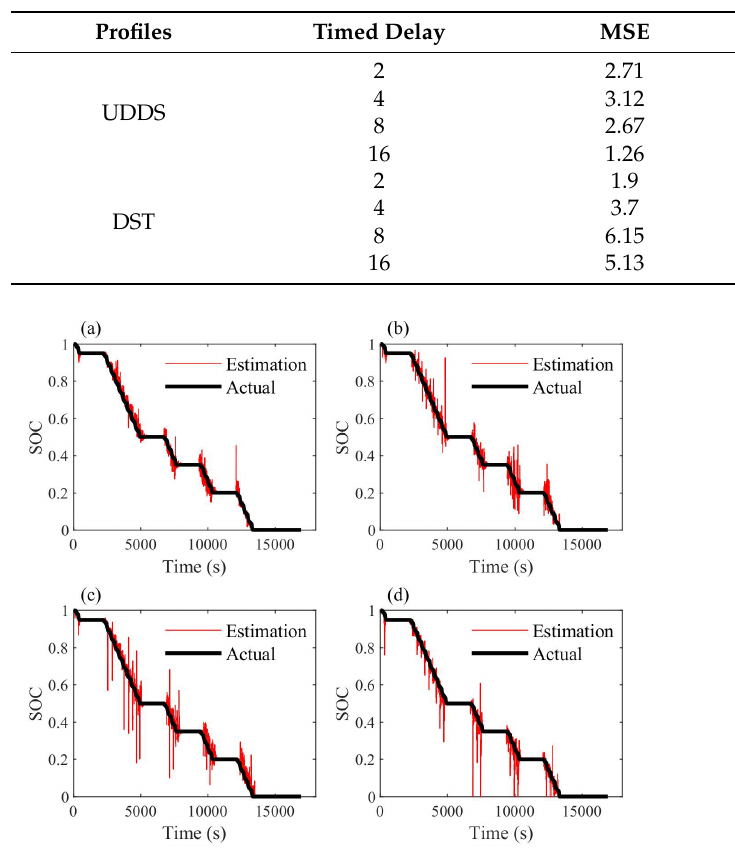
Figure 11. SOC estimation results for the UDDS profile generated by using a time-series neural network with different time delay parameters: ( a ) d = 2, ( b ) d = 4, ( c ) d = 8, and ( d ) d = 16. Table 4. Maximum error and MSE of the two profiles generated by using a time-series neural network with different time delay parameters.